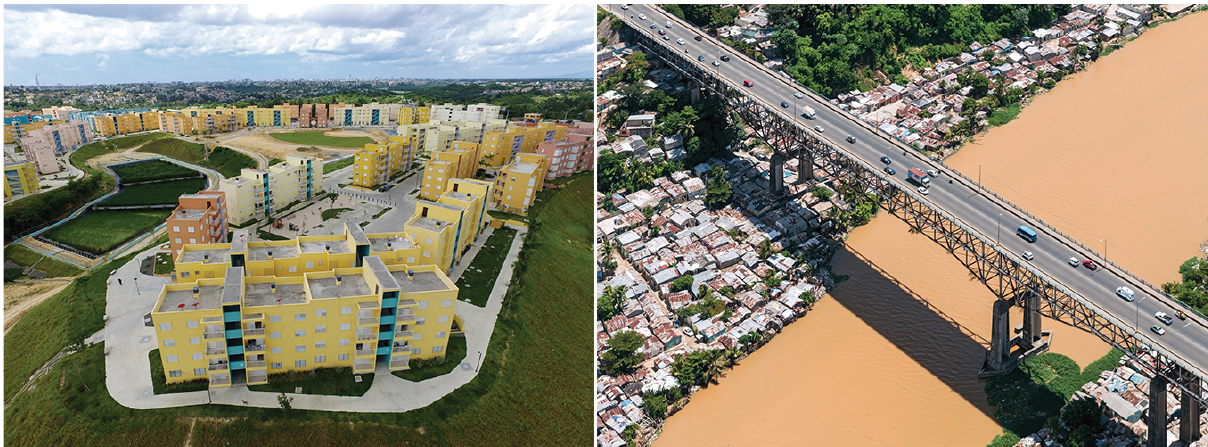
Figure 4. Contrasts between LNB and La Vieja Barquita neighbourhoods. Source: URBE (2017). Urban Planning, 2019, Volume 4, Issue 1, Pages